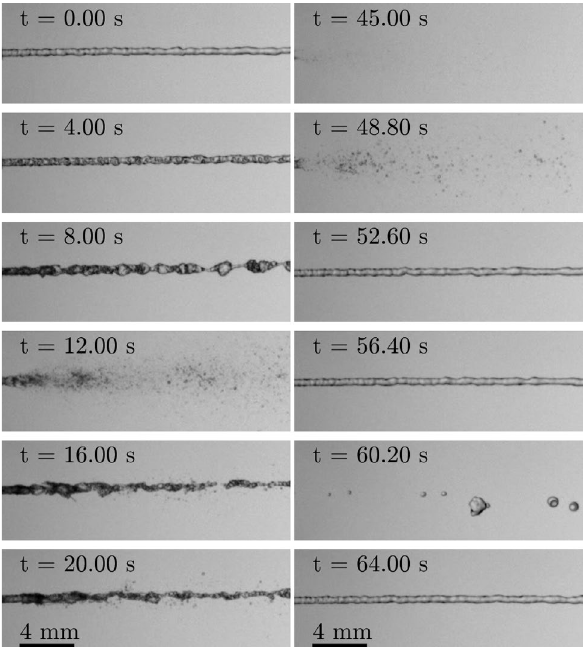
Figure 4. Temporal evolution of the outflow from the needle tip resulting from interrupting the connection between the outer tube and the vacuum pump at t = 0 , and after re-establishing the connection at t = 45s . Before interruption, the device operated in equilibrium at p l ≈ 1.6 bar and p g ≈ 0.8 bar corresponding to the operation shown in Fig. 3. The shown data during shut-off and re-start of the method correspond to the measurements shown in Fig.